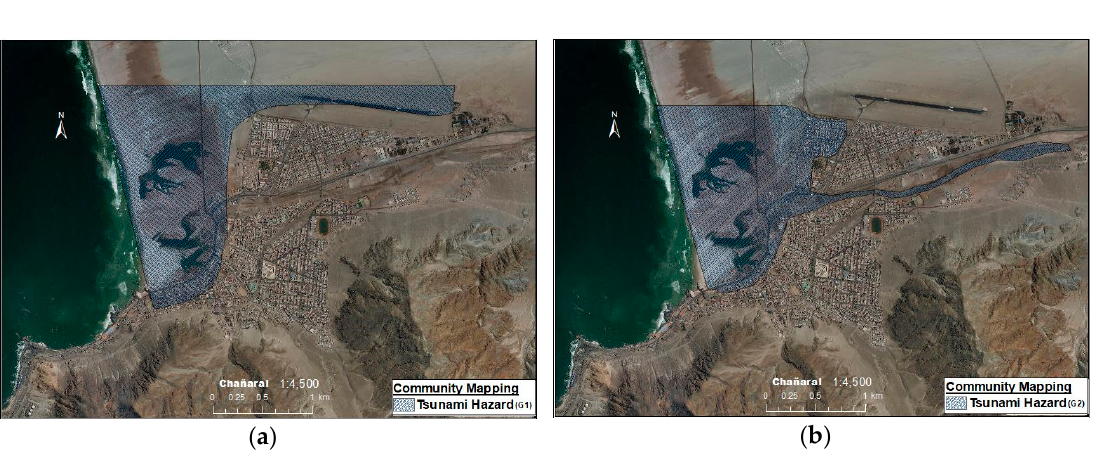
Figure 10. Tsunami risk perception in Chañaral: ( a ) Group 1, ( b ) Group 2.